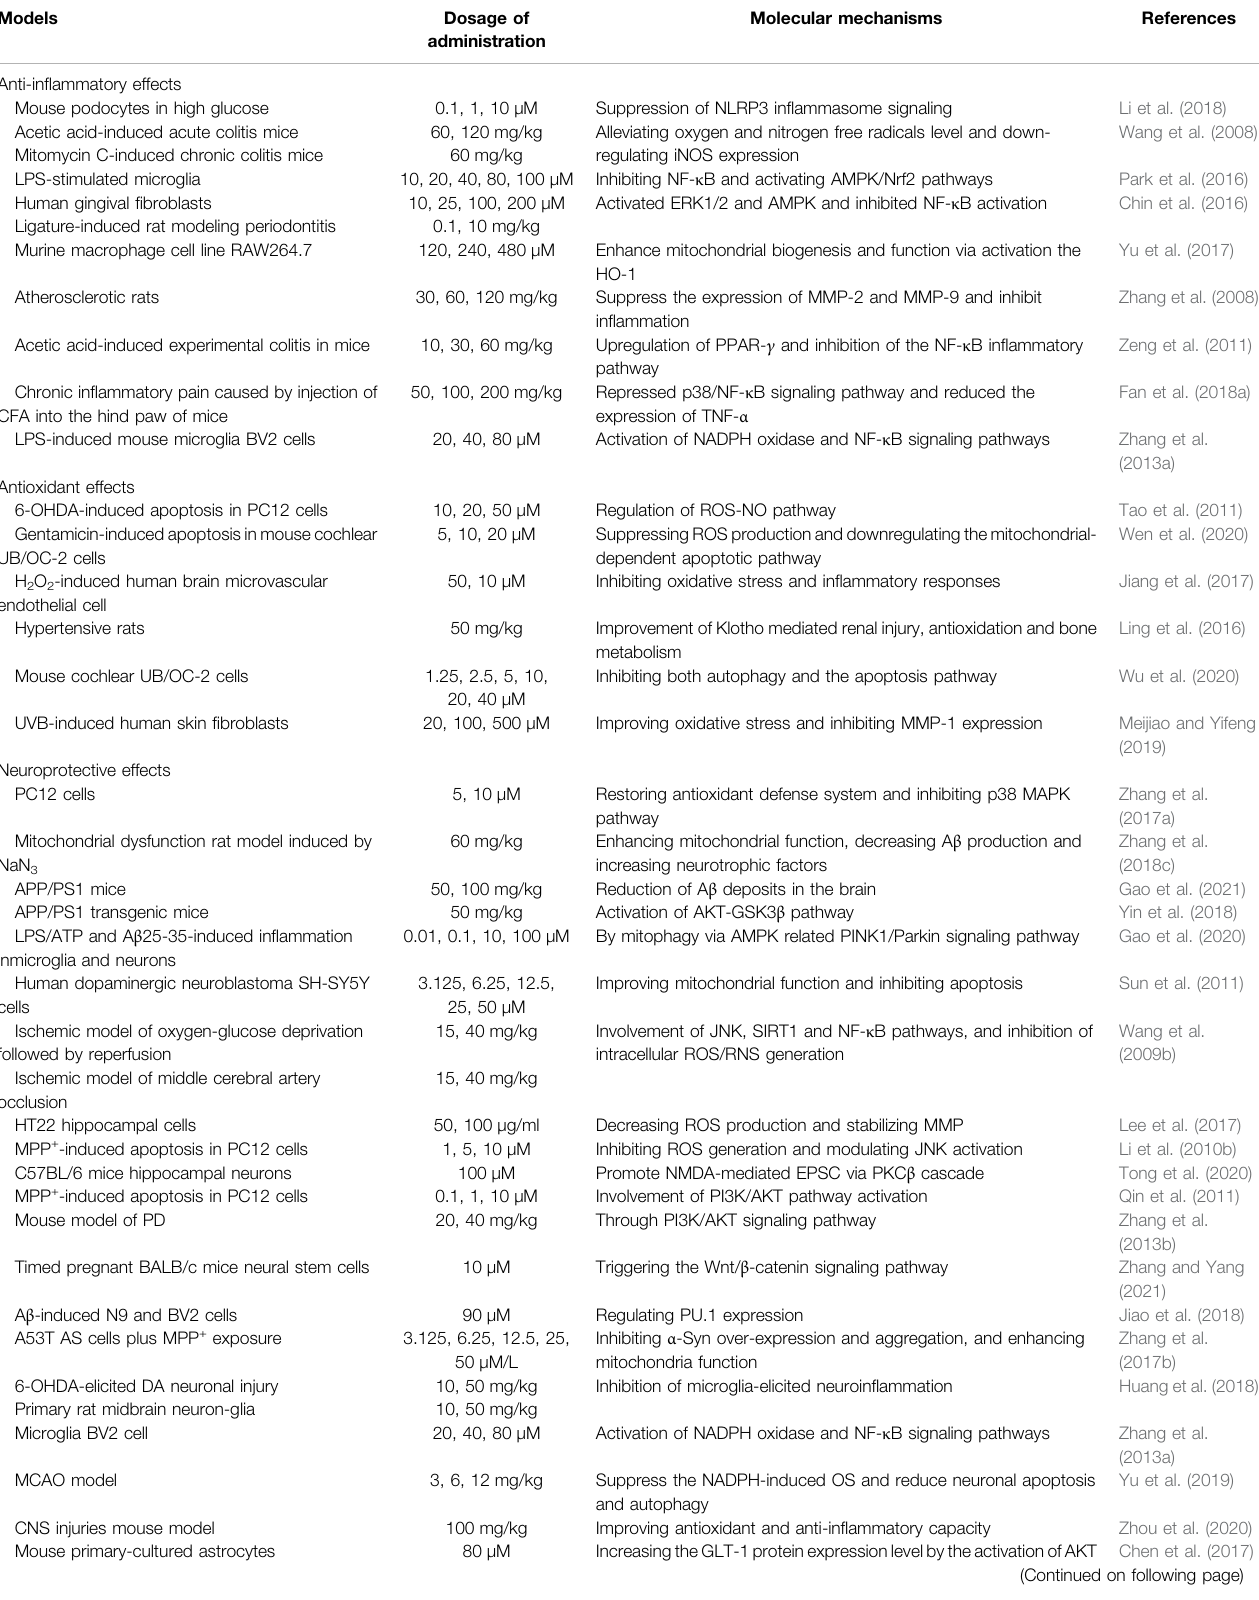
TABLE 2 | Molecular mechanisms to the pharmacological activity of